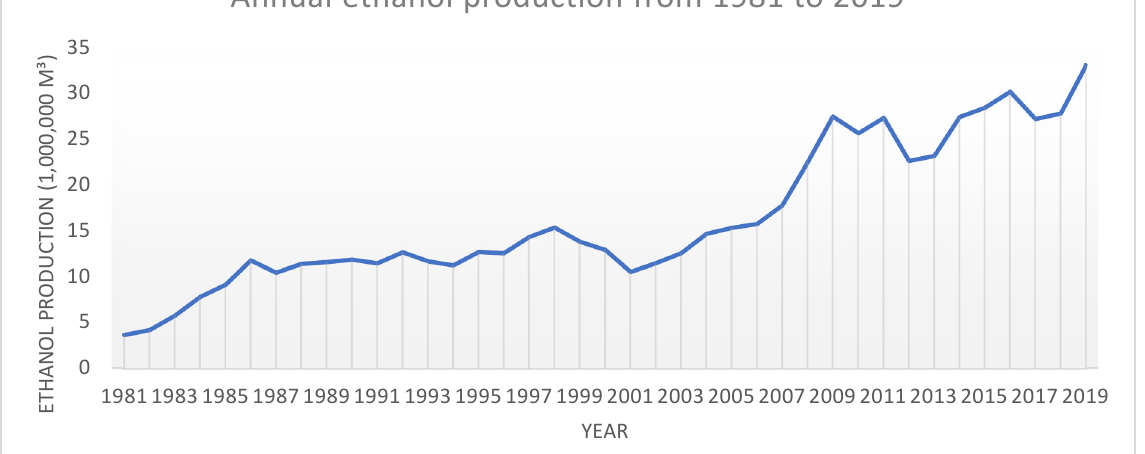
Figure 2. Annual ethanol production in Brazil from 1981 to 2019 [119].